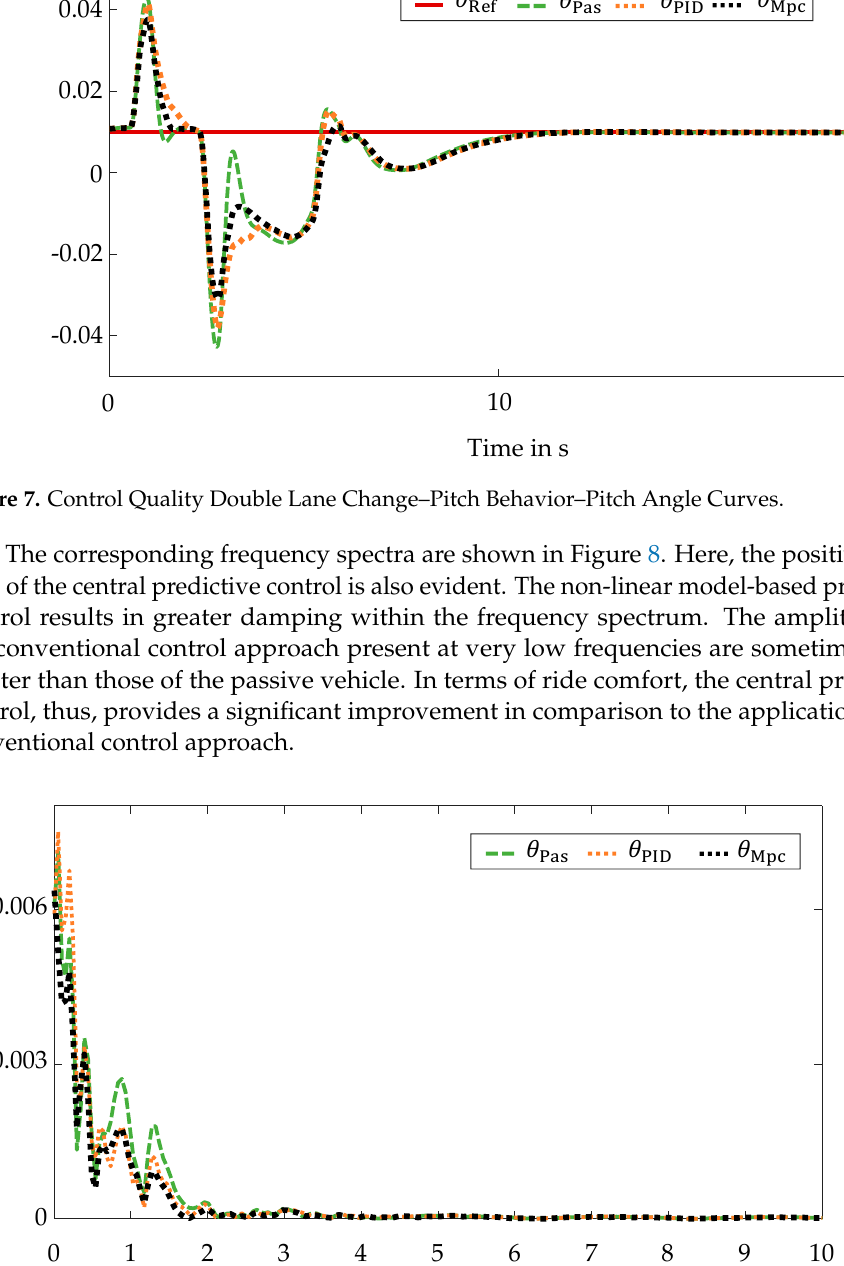
13 of 19 Figure 6. Control Quality Double Lane Change–Self-Steering Behavior–Frequency Spectra. 4.2.3. Pitch Behavior Similar to the manipulation of the self-steering behavior, the reduction of pitching movements is a subordinate control objective within the non-linear model-based predic-